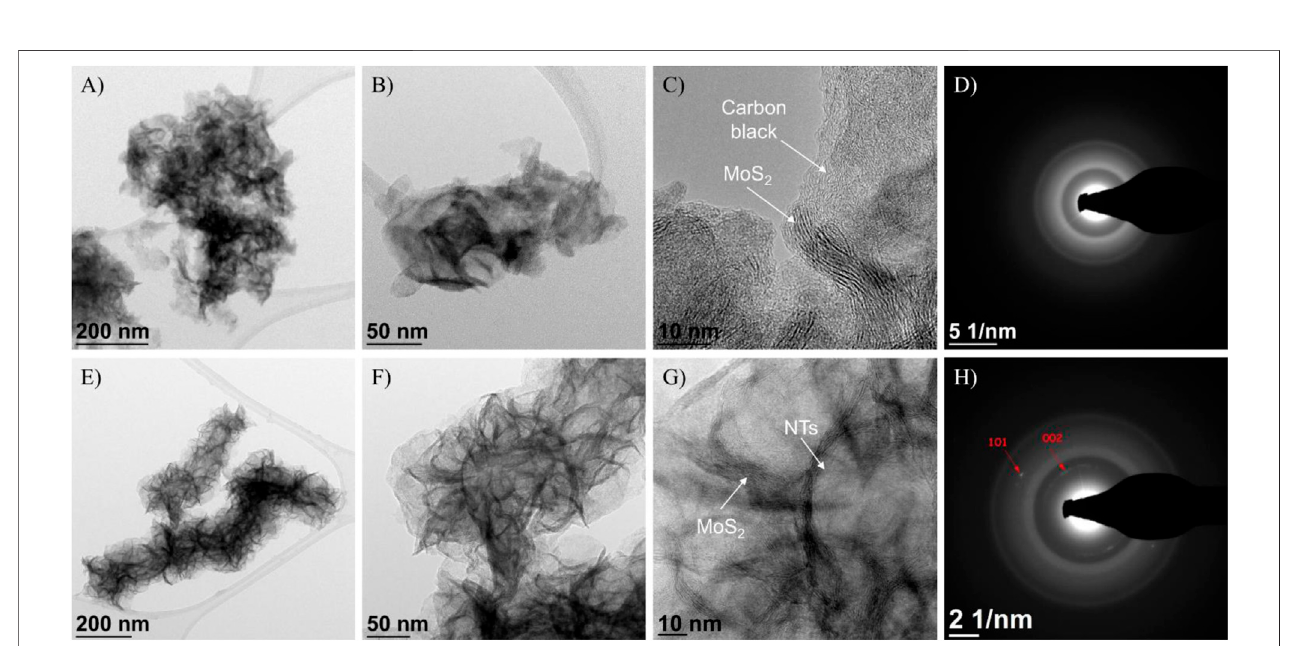
FIGURE 5 | TEM and SAED images of BP2000/MoS 2 — (A) – (D) and NTs/MoS 2 — (E) – (H) .